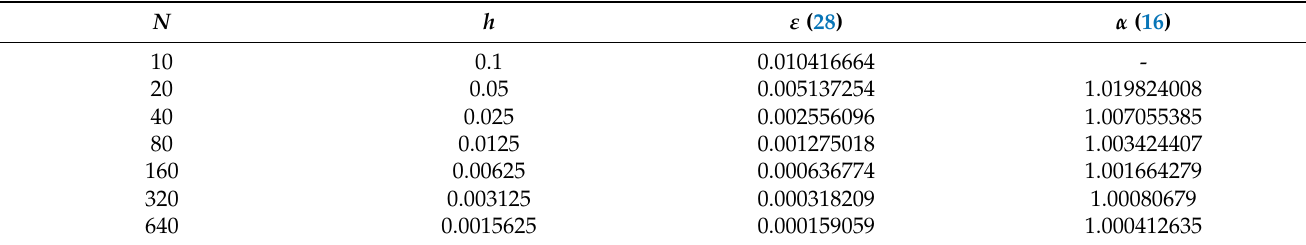
Table 4. Error and computational accuracy of scheme